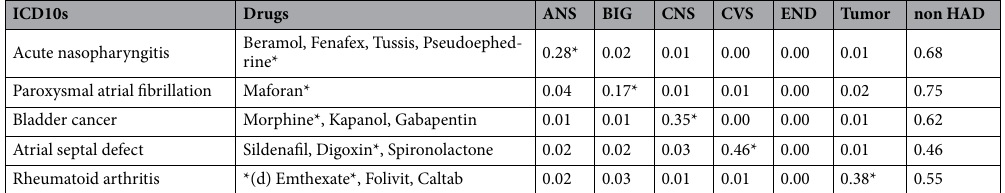
Table 4. Model prediction of HAD types.